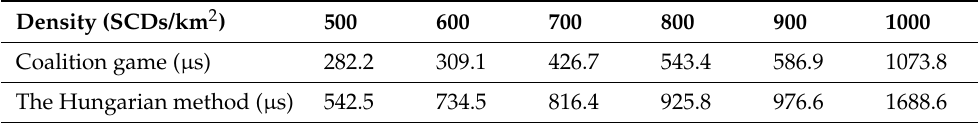
Table 7. The execution time of the clustering-method-based coalition game and SCA-based Hungarian method for different network